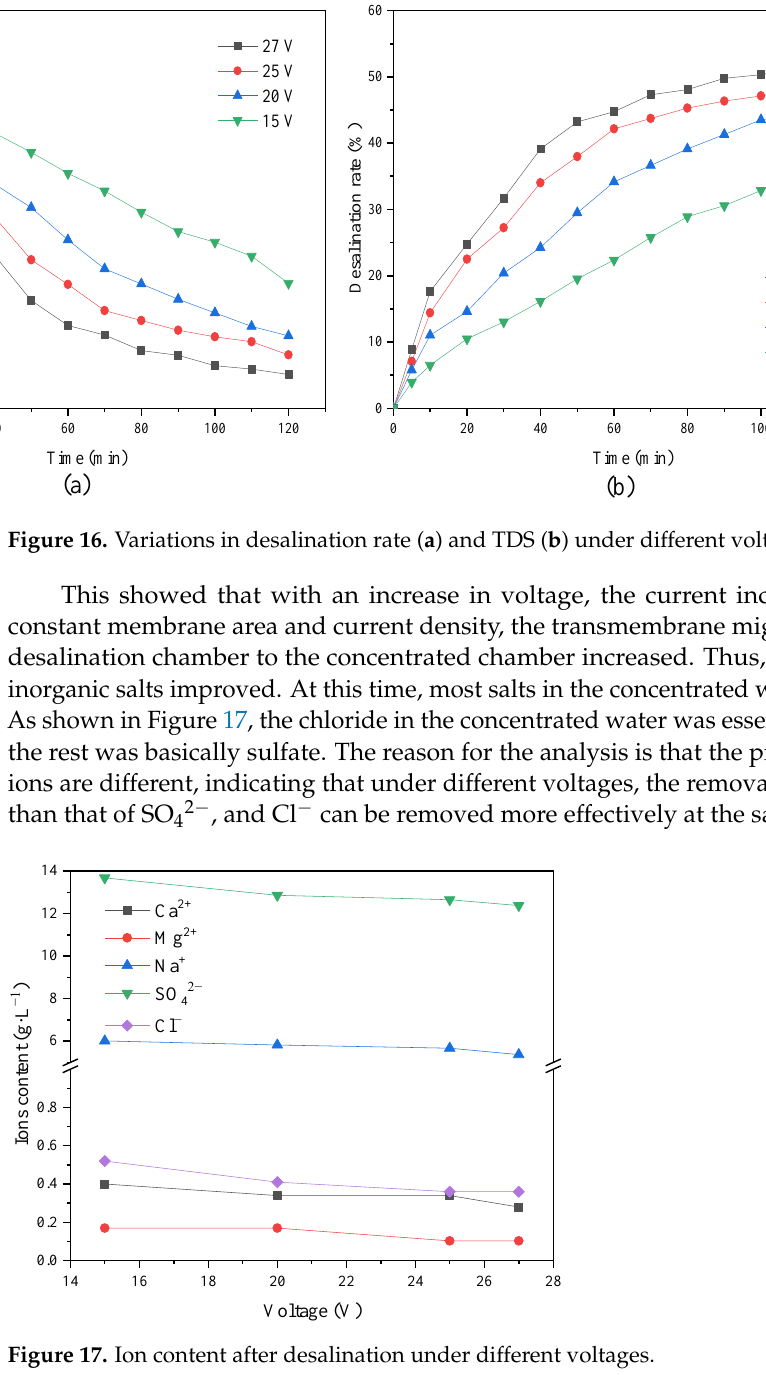
concentrated water increased by 15%. Figure 15. Conductivity of the fresh cells with different voltage changes with time.